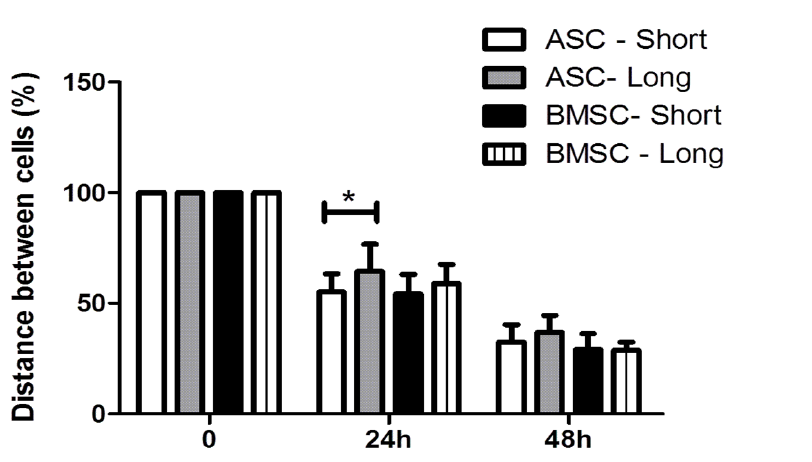
Figure 3. Cell migration after induced injury in the adherent cell layer. The measurement was presented in % of space between the extremities of the lesion. Evaluation at 0, 24, 48 and 72 h. The lesion was fully repaired after 72 hours. Data is presented as mean ± S.D.* p <0.05 (n =